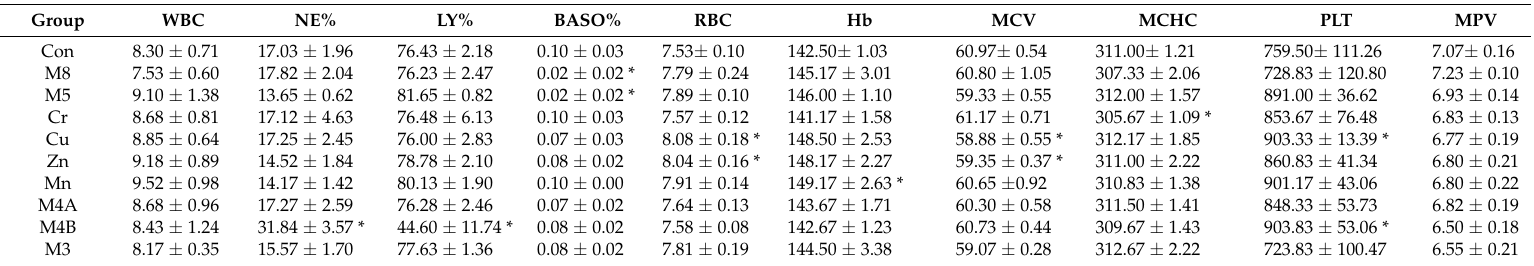
Table 3. Hematological effects of different